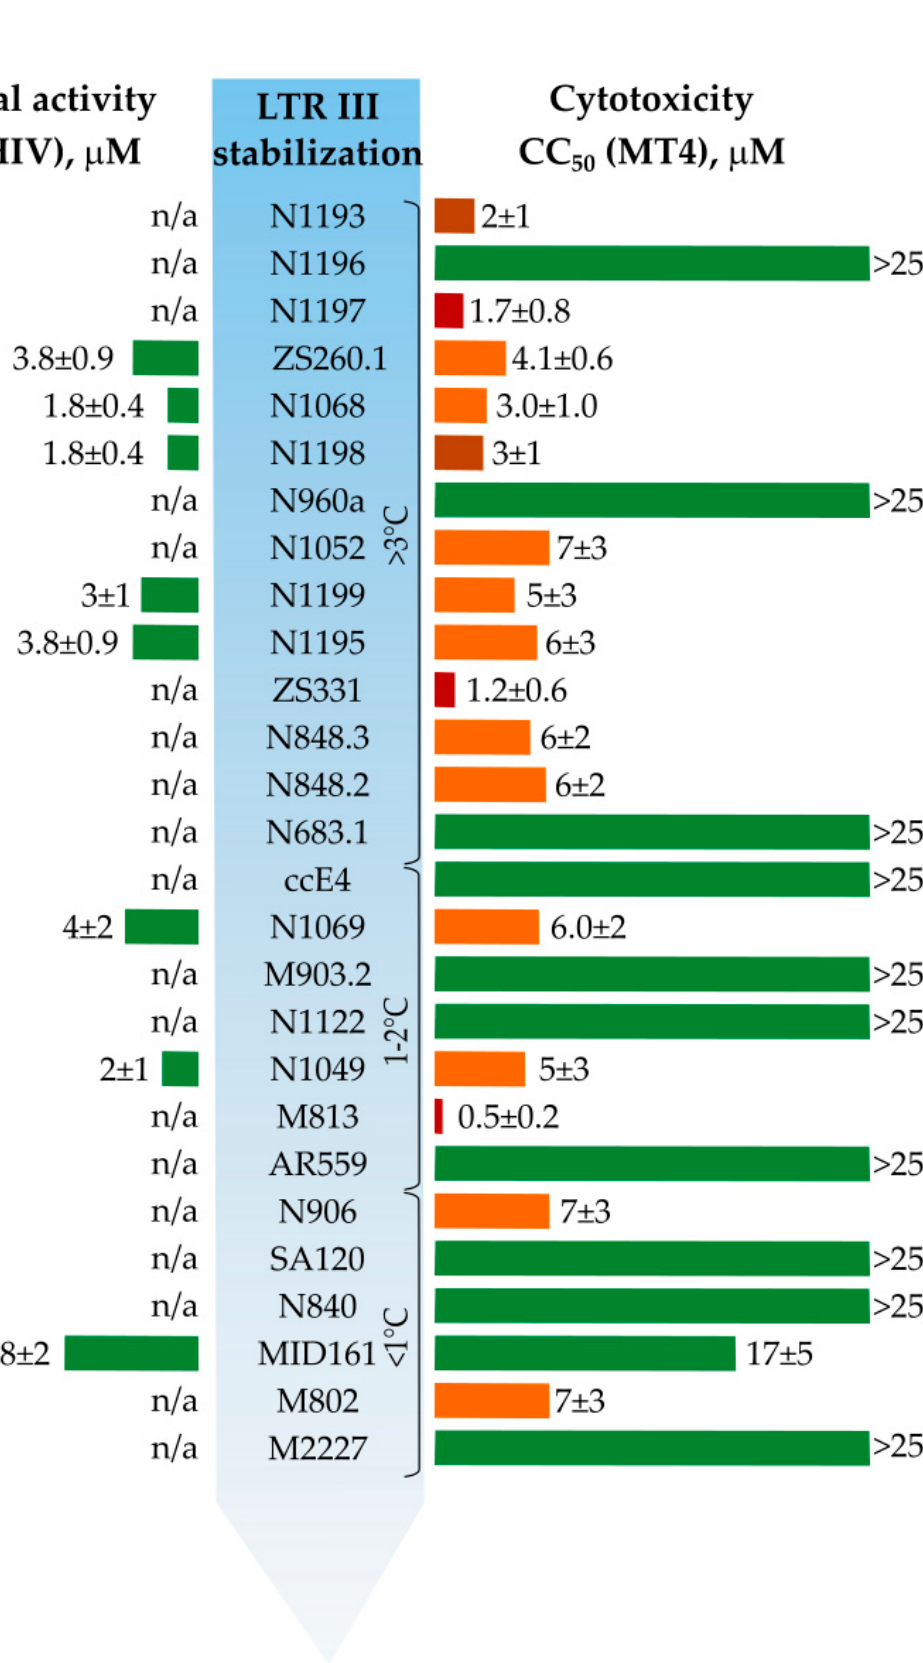
Figure 7. Thermal stabilization, cytotoxicity, and antiviral activity of the tested compounds in MT4 cells against HIV-1 (st. NL4-3). n/a—not active in non-toxic concentrations.